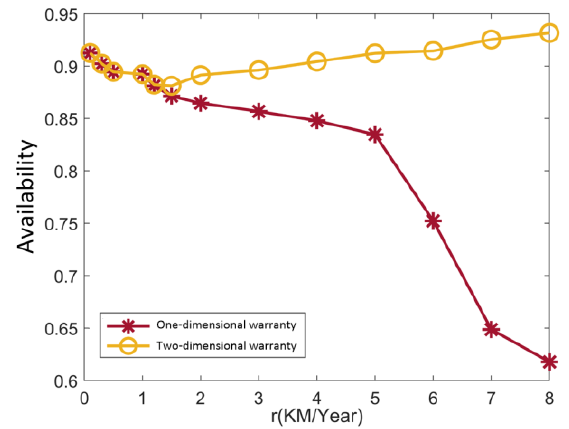
Figure 20. Comparison of availability under different warranty methods.